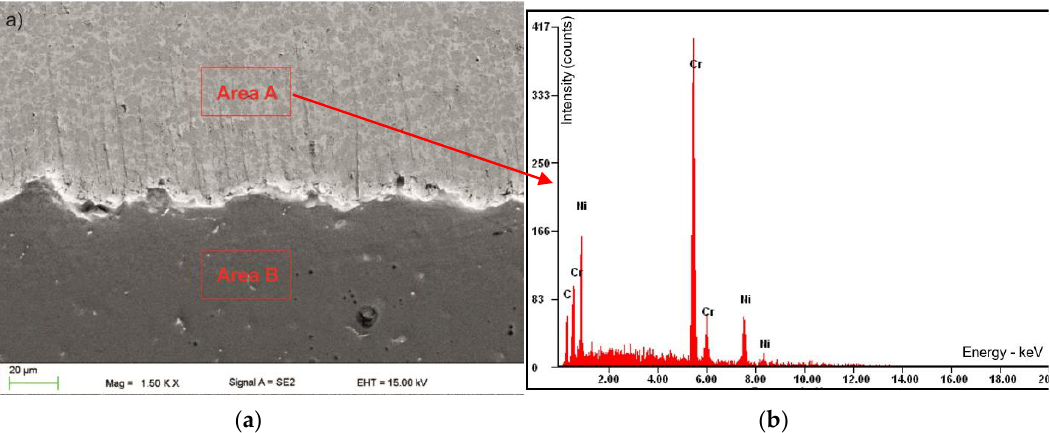
Figure 4. SEM cross-section images: area “A” coating and area “B” substrate ( a ) and the ( b ) EDS analysis of the coating. Table 2. Chemical composition of layer and substrate from the Figure 5.